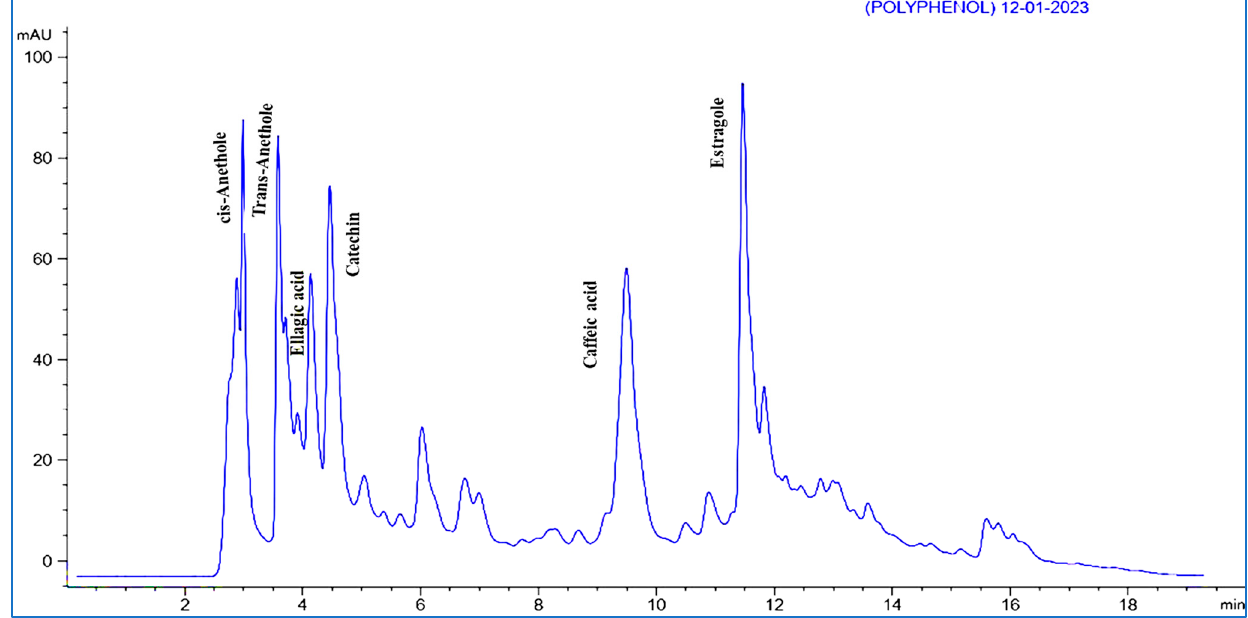
Figure 2. Chromatogram of aniseed HPLC. Estragole, cis-anethole, and trans-anethole had the highest RTs at 11.52, 2.82, and 3.55, respectively.